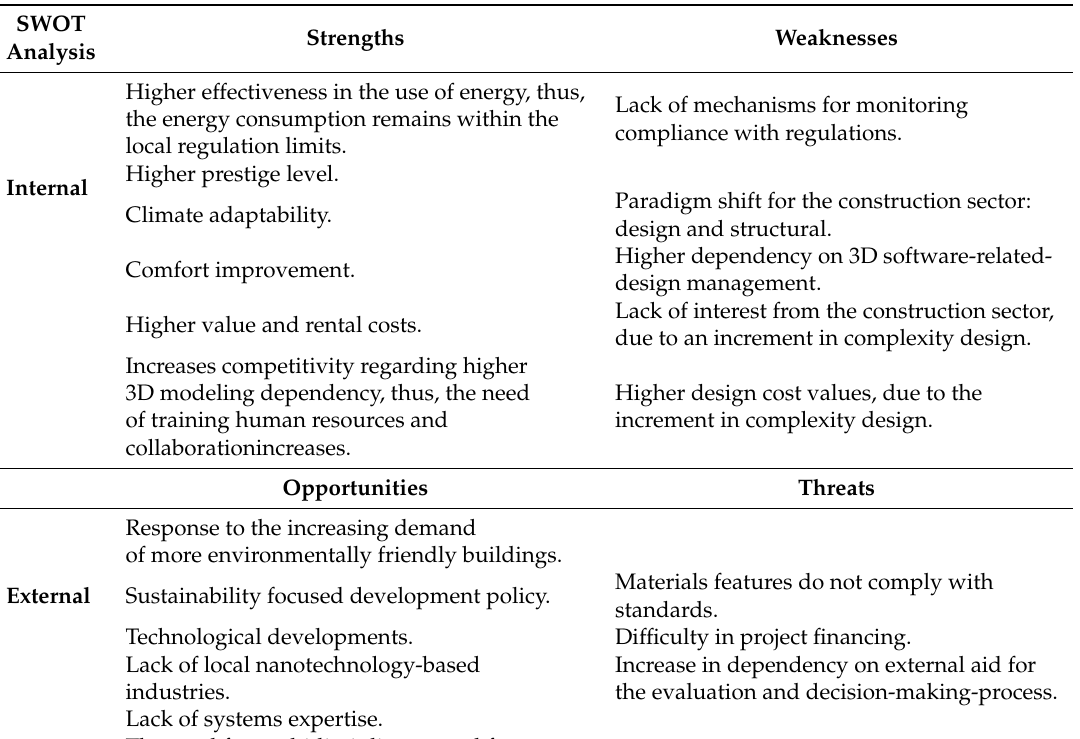
Table 3. SWOT analysis applied for the introduction of biomimicry approaches to building designs (based on [70], and adapted to our context in